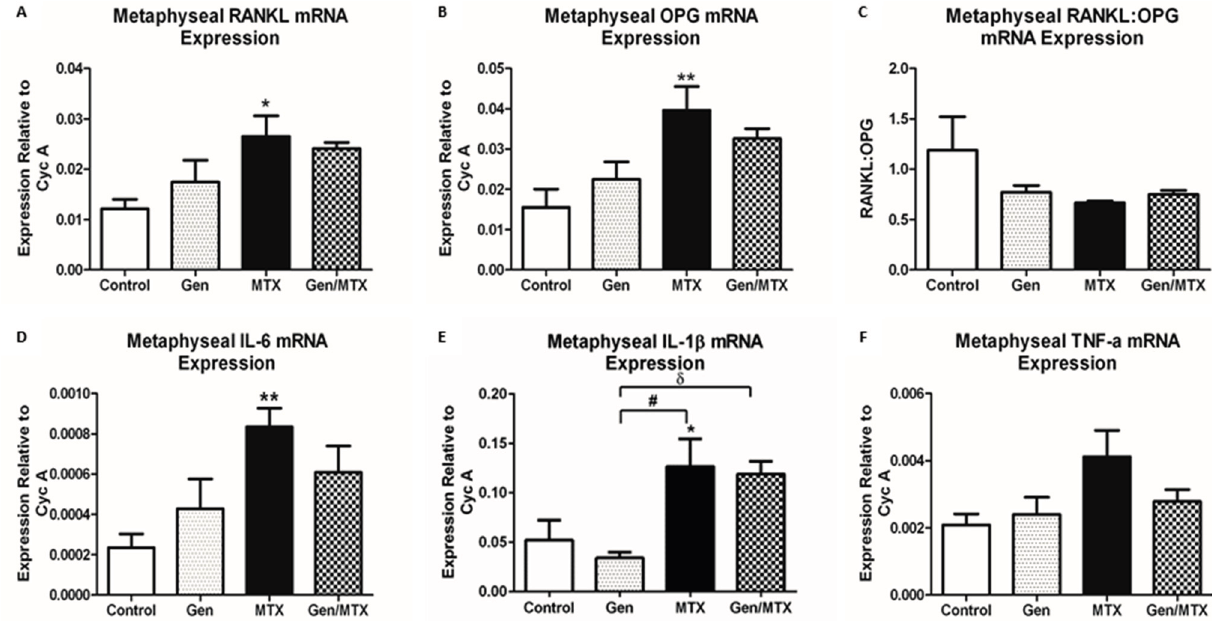
Figure 5. MTX administration increased mRNA expression of receptor activator of NF- κ B ligand (RANKL), osteoprotogerin (OPG), interleukin-6 (IL-6), and IL-1 β in the metaphysis bone compared to control rats. ( A , B ) Quantitative RT-PCR of osteoclastogenesis regulators RANKL and OPG, respectively, within the metaphysis; ( C ) Ratio of relative mRNA expression of RANKL to OPG; ( D – F ) Quantitative RT-PCR of pro-inflammatory cytokines IL-6, IL-1 β , and tumor necrosis factor-alpha (TNF- α ), respectively. n = 6, * p < 0.05 and ** p < 0.01 vs. control; # p < 0.01 between Gen and MTX alone groups, and δ p < 0.05 between Gen alone and Gen/MTX